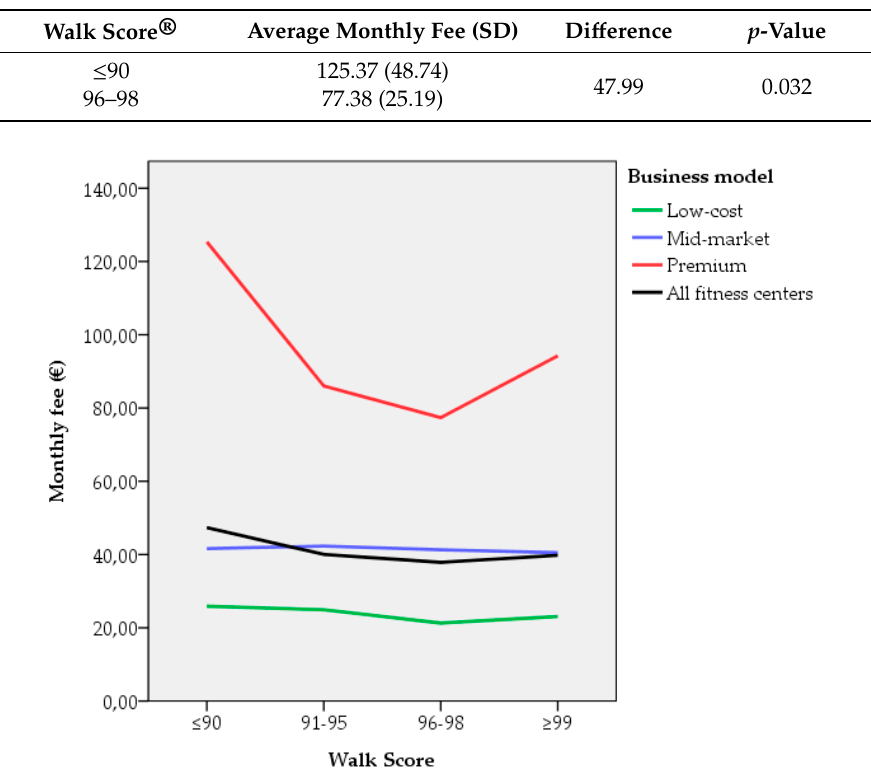
Figure 4. Monthly fee according to Walk Score ® .